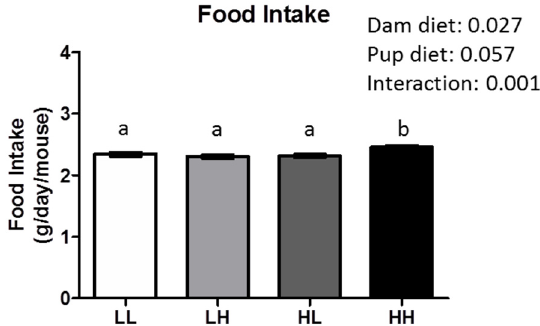
Figure A1. High maternal dietary vitamin D increased food intake in female offspring at 7 months of age. Groups are labeled as LL and HH for offspring receiving low vitamin D or high vitamin D from conception until adulthood (25 IU/kg diet or 5000 IU/kg diet, respectively), or switched post-weaning (LH and HL). Two-way ANOVA was utilized with “dam diet” and “pup diet” as main effects. Values are given as mean ± SEM. Significance between groups set at p < 0.05; different letters indicate significance between groups.